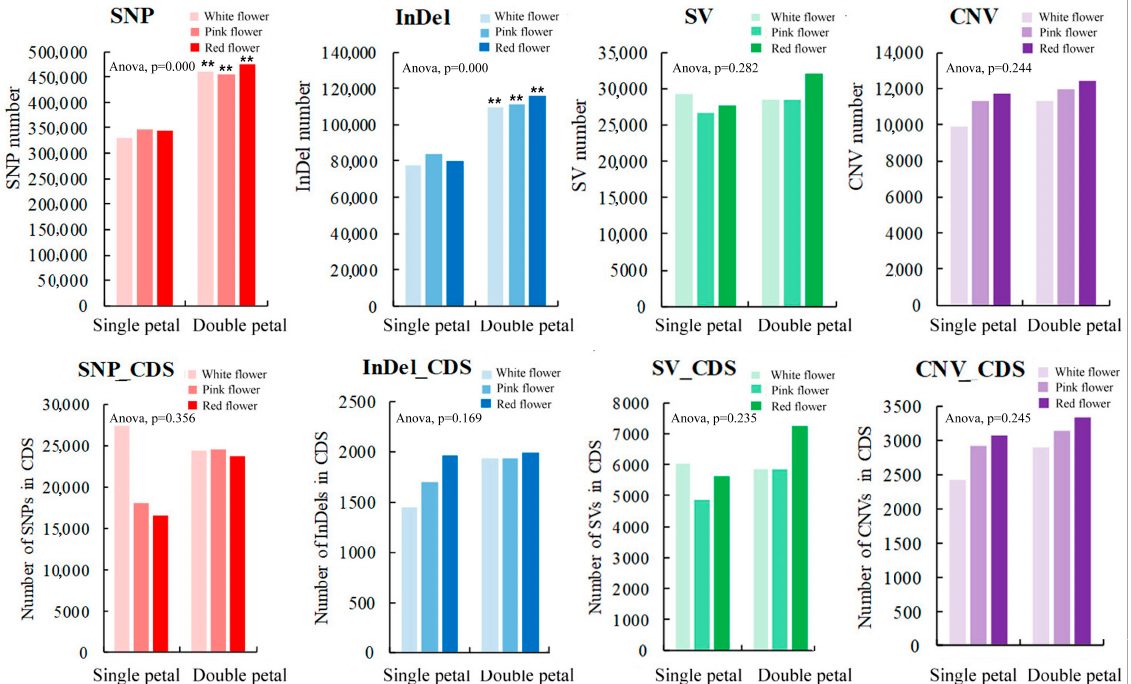
Figure 2. Quantitative statistics of 4 variation types of six ornamental pomegranate varieties. Two asterisks indicated significant differences at p < 0.01, between the two types of flowers (single- and double-petals) according to the Duncan test.